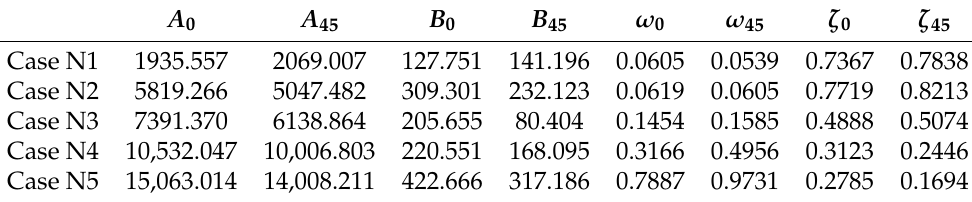
Table 1. Input parameters for Equation (1) fitting the Murzenko data for loading cases